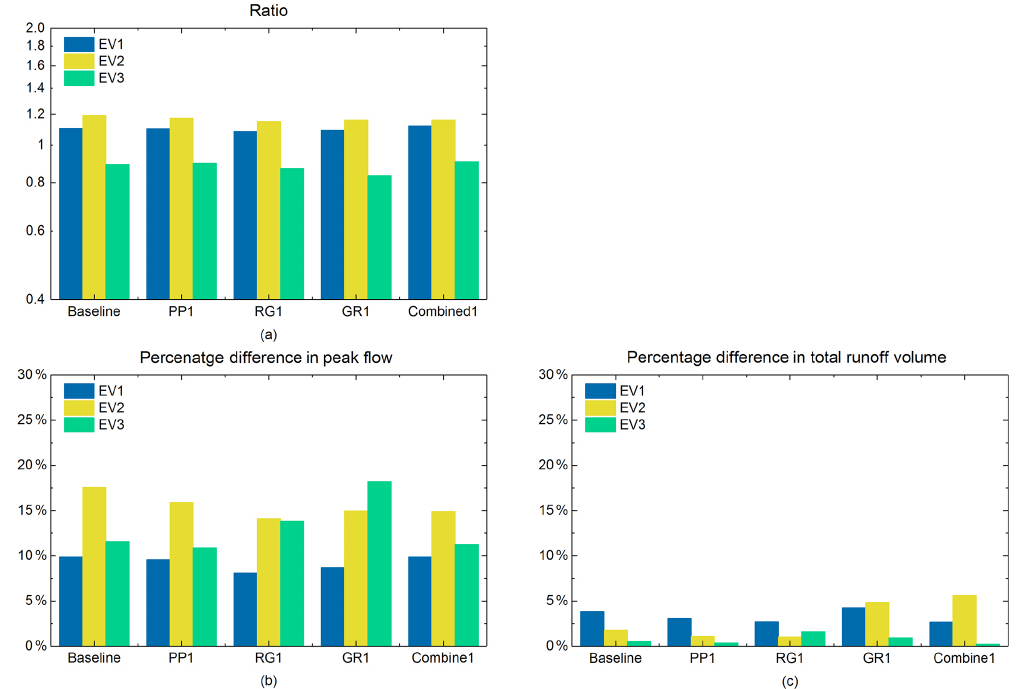
Figure 13. (a) The ratio of peak flow between the scenarios under the distributed rainfall and the scenarios under the uniform rainfall. (b) Percentage difference in peak flow of the baseline scenario and the first set of NBS scenarios under the three distributed rainfall events and the three uniform rainfall events. (c) Percentage difference in total runoff volume of the baseline scenario and the first set of NBS scenarios under the three distributed rainfall events and the three uniform rainfall